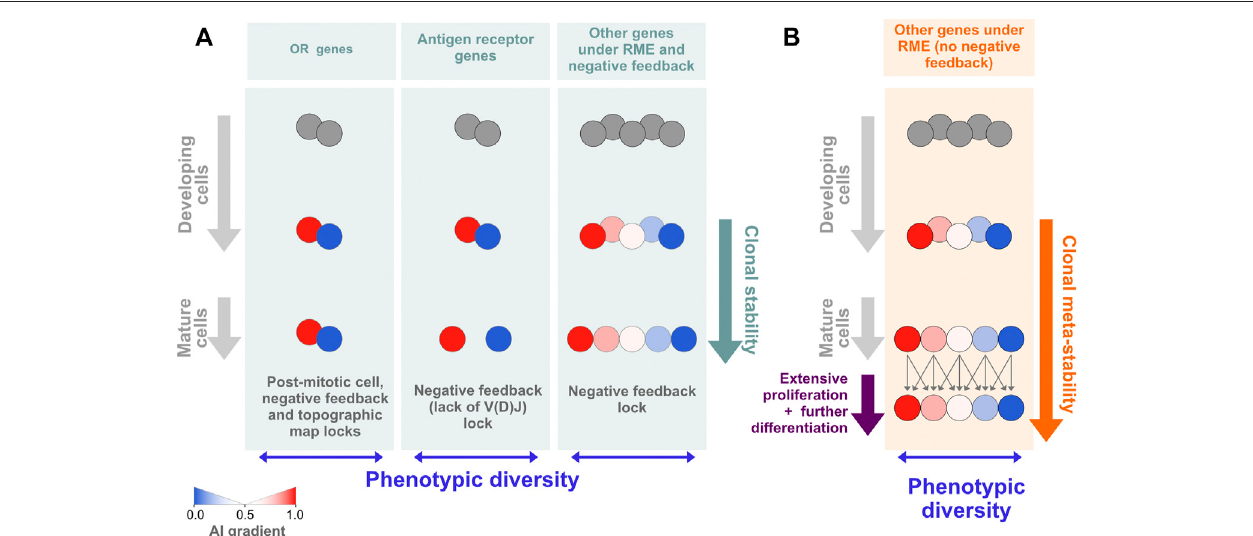
FIGURE6| Models ofRME. (A) Formostautosomal genesunder RME, theepigeneticstates leadingtoallelicbiasesareestablished de novo duringdifferentiation and shortly beforethe genesareexpressed. Thismodel ofRMEischaracterizedbydocumented(e.g.,olfactory receptor and antigenreceptor genes)orprobableclonal stabilityduetotheexistenceoflocksthatstabilizetheAI[reviewedin(Barretoetal.,2021)].Onenotablelockisthenegativefeedbacktriggeredbytheproteinexpression ofoneallelicform thatprevents furthergeneor allelic activation (orrecombination, inthecase oftheantigenreceptors). (B) Amodel ofRME inwhich theAIforeach cloneis meta-stable, i.e., it can change within a certain range during extensive periods of proliferation and differentiation. Assuming that HSCs have an initial percentage of genes under RME close to that estimated for cells from collections of developmentally frozen clones grown in vitro , our data are compatible with a meta-stable model of